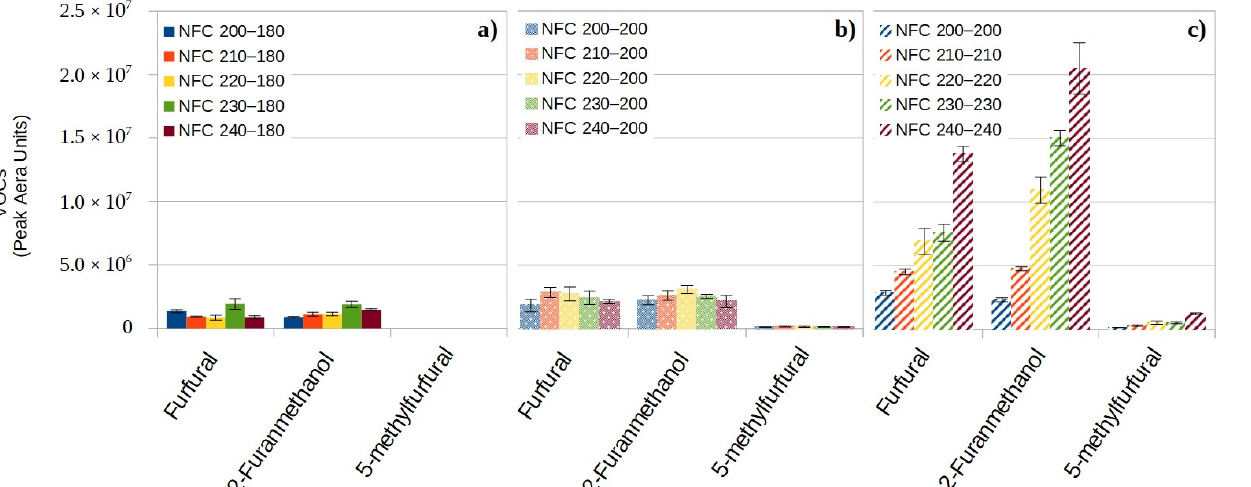
temperature of 200 ◦ C to 240 ◦ C, the results in Figure 5c show that the higher the heat press temperatures, the greater the presence of 2-methylfurfural, 2-furanmethanol and furfural. Between a thermocompression at 200 ◦ C and one at 240 ◦ C, the quantities